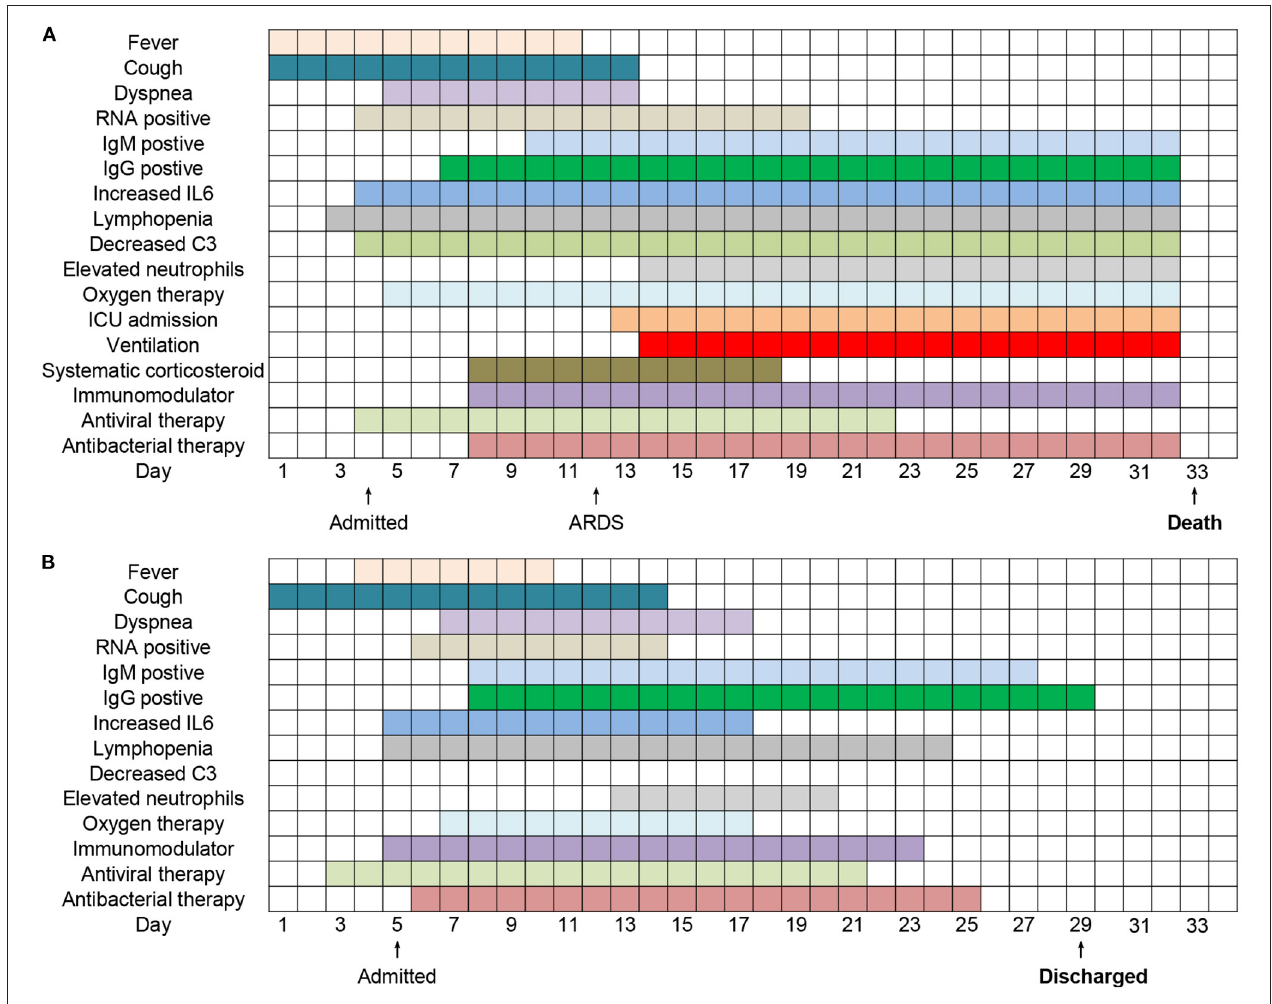
FIGURE 3 | Clinical courses of 2 typical hospitalized patients (A,B) with COVID-19 from illness